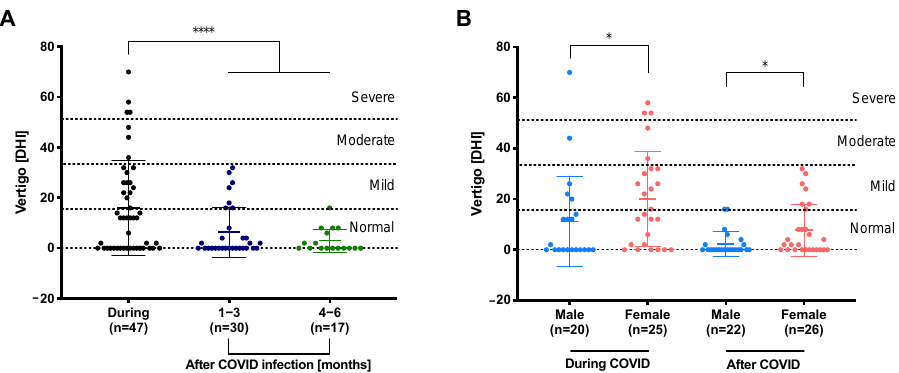
Figure 2. Influence of COVID-19 on the sense of balance. All patients were asked to classify their vertigo symptoms both during and after COVID-19 using the Dizziness Handicap Inventory, a 25-item multiple choice questionnaire. ( A ) During COVID-19, more than half of patients reported having at least mild symptoms of dizziness that improved during the initial six months following COVID-19. ( B ) Women experienced significantly more balance disorders than men both during and after COVID-19 (* p < 0.05, **** p < 0.0001).